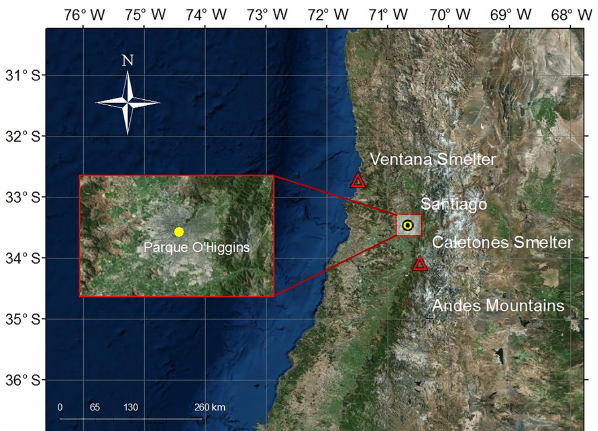
Figure 1. Map of Santiago region, Chile, with the metropolitan area indicated by the red rectangle, and the yellow circle showing the lo- cation of the monitoring site in Parque O’Higgins. The red triangles show the location of the major copper smelters close to